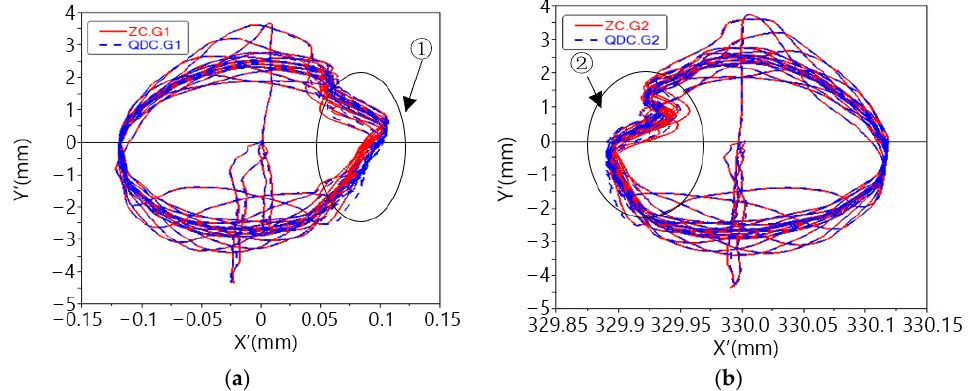
Figure 9. Position curve of gear rotation center in x’ y’ coordinate system: ( a ) driving gear and ( b ) driven gear.